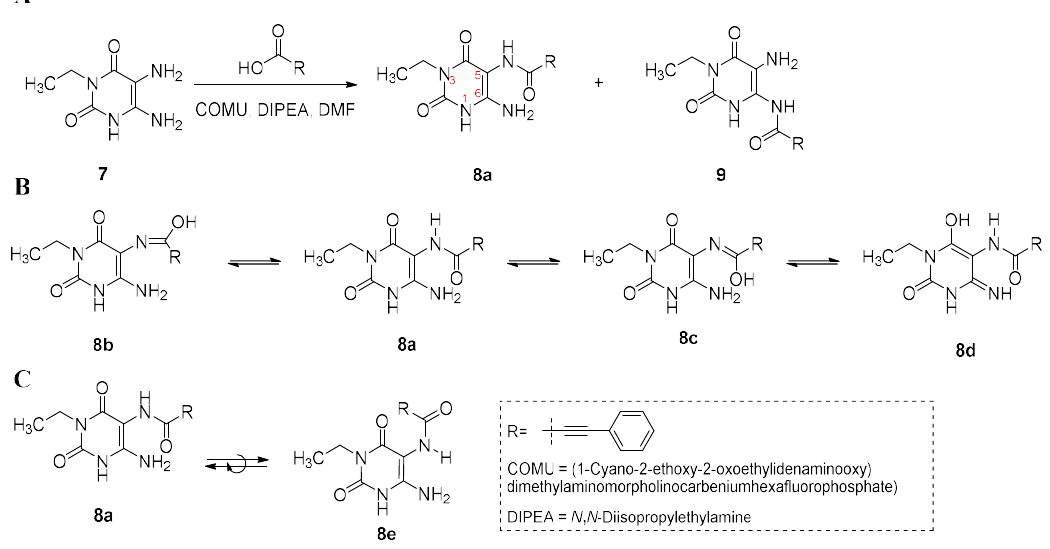
Figure 2. 1 H-NMR spectra of compound 8a in DMSO- d 6 .